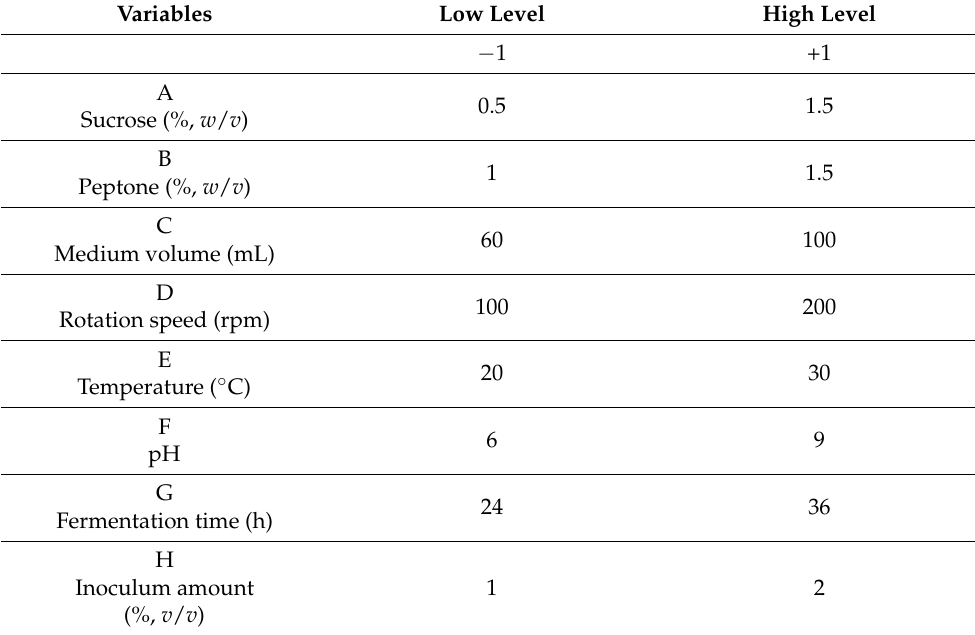
Table 1. Different level of variables in Plackett–Burman design.